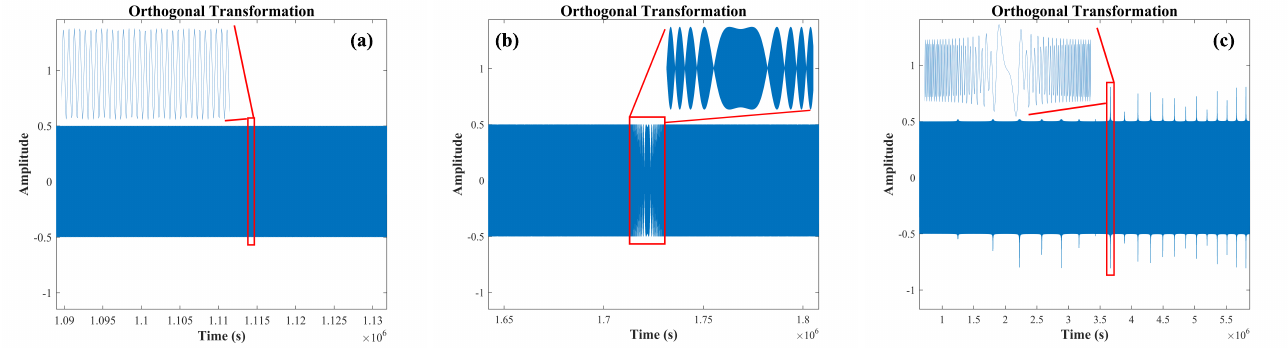
Figure 3. Orthogonal transformation of HT signals: ( a ) OT signal of first order, ( b ) OT signal of second order, ( c ) OT signal of third